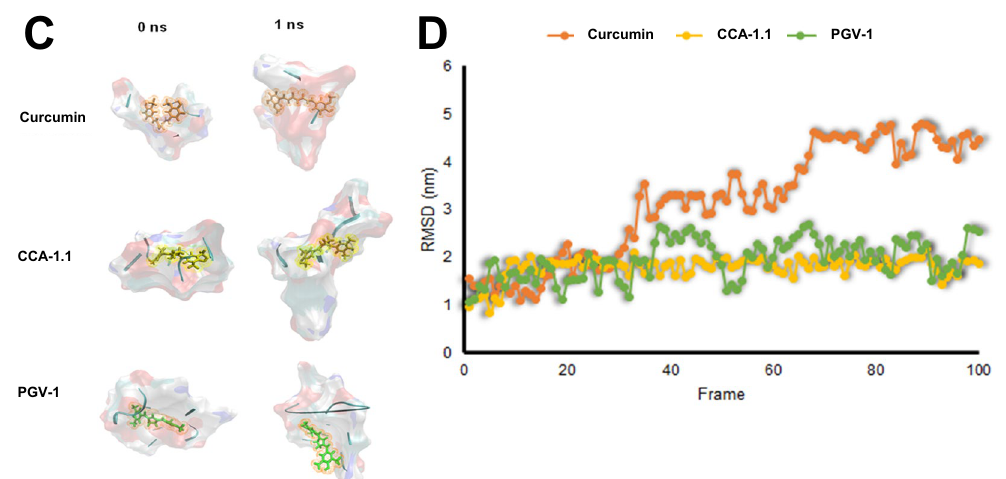
Figure 7. ( A ) 3D visualization of EGFR mutations, E709K (Glu709 Lys709), T263P (Thr263 Pro263), V774M (Val774 Met774), and L861Q (Leu861 Gln861). ( B ) Visualization of molecular docking results for wild-type EGFR and mutant EGFR (E709K, T263P, V774M, and L861Q) against Curcumin, CCA-1.1, and PGV-1. ( C ) Visualization of the binding interaction of compounds (Curcumin, CCA-1.1, and PGV-1) against mutant EGFR L861Q at the initial time and after 1 ns MD simulation. ( D ) Root mean squared deviation (RMSD) of compounds (Curcumin, CCA-1.1, and PGV-1) in complex with mutant EGFR L861Q after 1 ns MD, shown in 100